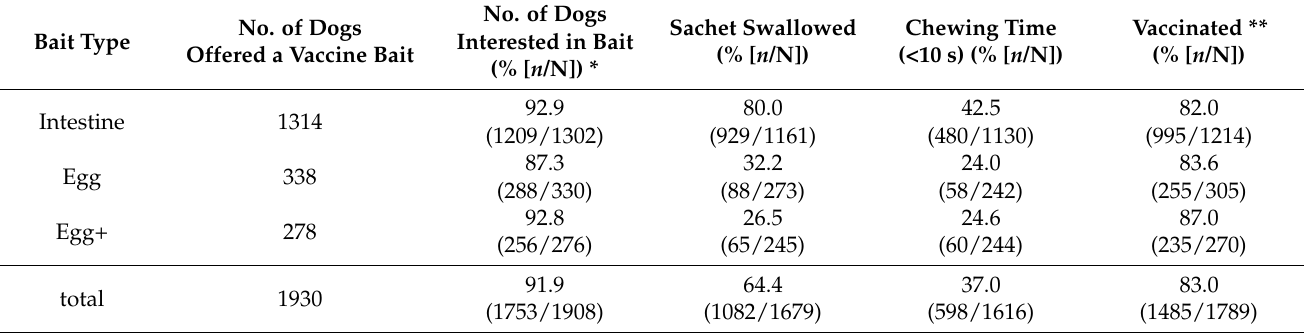
Table 1. Percentage of dogs interested in bait offered, dogs that chewed very shorty (<10 s), swallowed the sachet and considered vaccinated per bait type offered; intestine bait, egg bait, and egg+ bait (%—percentage, n —number of animals with positive result, N—total sample